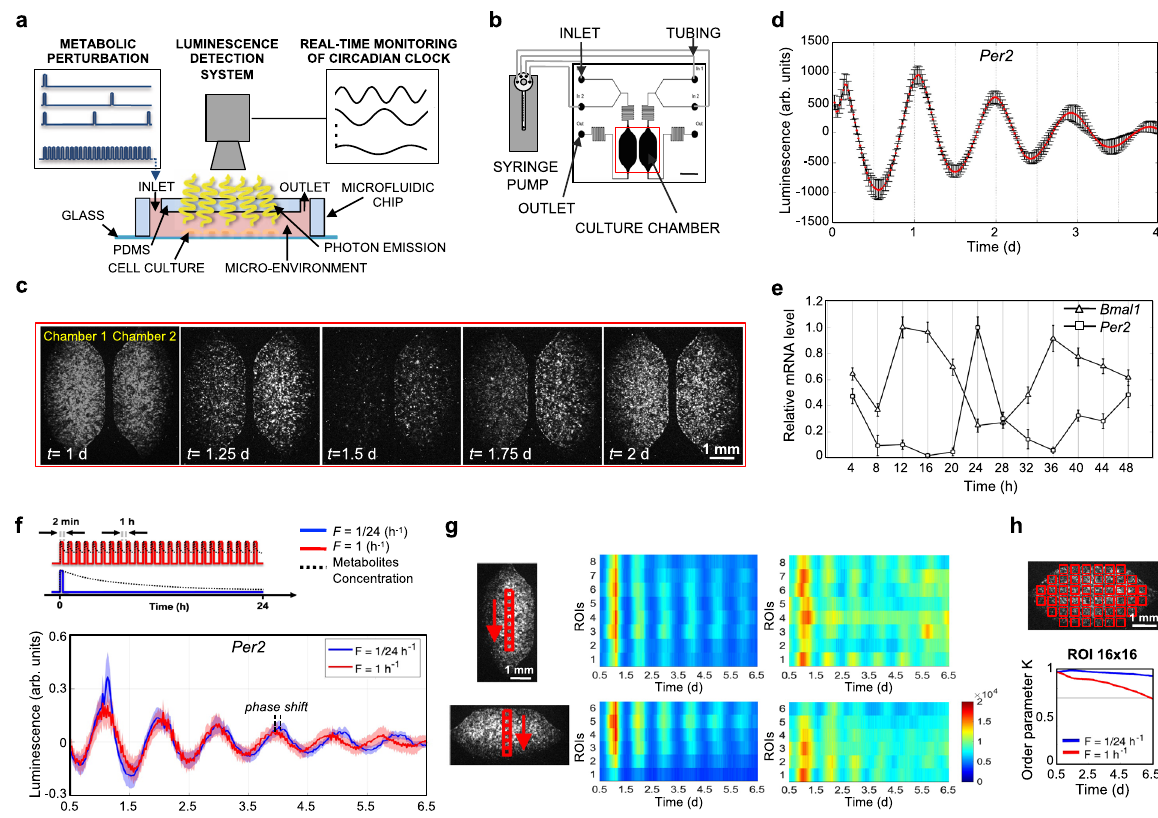
Fig. 1 Real-time luminescence recording for live measurement of clock gene dynamics. a Schematic representation of experimental setup for the acquisition of bioluminescence signal from cell integrated micro fl uidic chip; micro fl uidic setup is coupled with a microscope and liquid handling system. b Schematic representation of the liquid handling system connected to the micro fl uidic device, composed of two independent culture chambers (two inlets and one outlet for each). Scale bar 2.5 mm. c Time-lapse of bioluminescence images of a representative experiment, captured every 30 min, of mouse Per2::Luc fi broblasts, showing circadian rhythms of luminescence for 2 days. Scale bar 1 mm. d Baseline-subtracted Per2::Luc bioluminescence patterns acquired for 4 days from a micro fl uidic chamber after dexamethasone shock. Data are represented as mean ± s.d., N = 9 for each condition. e Temporal pro fi les of clock gene expressions, BMAL1 and PER2, in human fi broblasts integrated in the micro fl uidic platform, after synchronization ( t = 0)